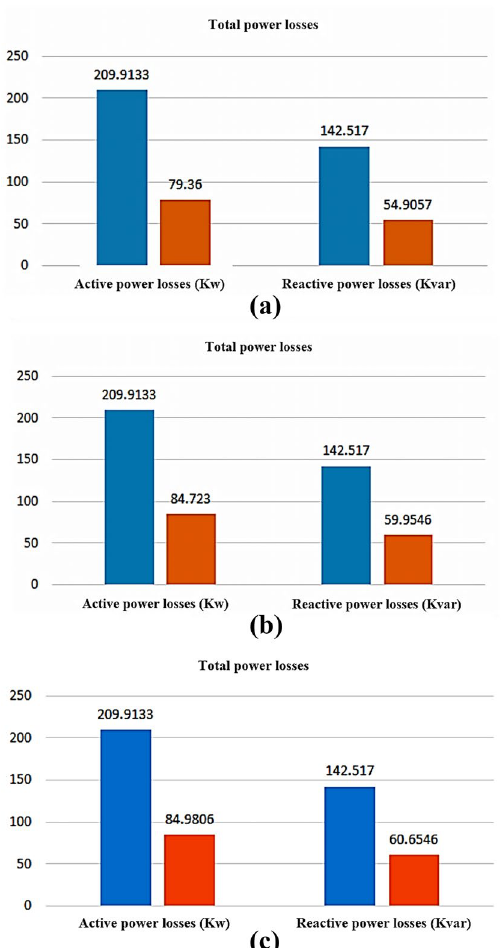
Fig. 8 The graph of total power losses in the 33-bus network, a unit resulting, b 0.85 Post-phase, c 0.85